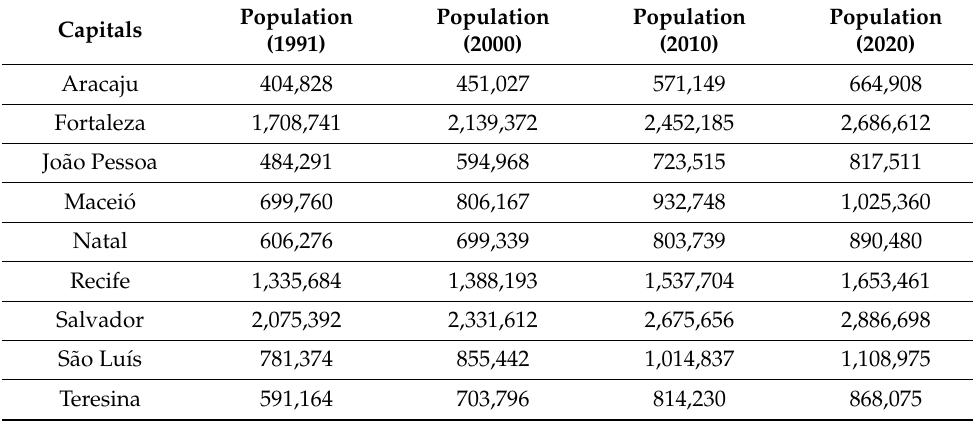
Table 1. Estimated population for NEB capitals. Source: [32].